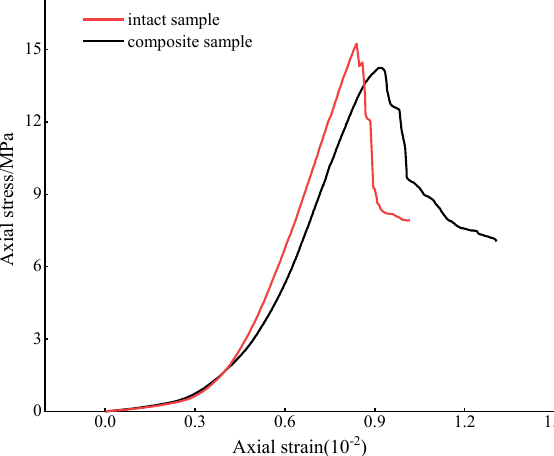
Figure 3. Stress−strain curves of intact sample and composite sample.